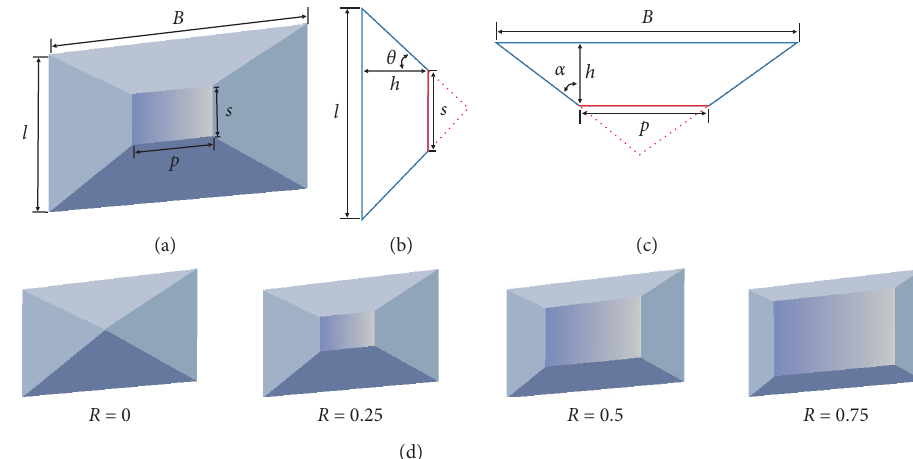
Figure 1: Basic pyramidal element: (a) overall view, (b) side view, (c) top view, and (d) different shapes caused by the change of